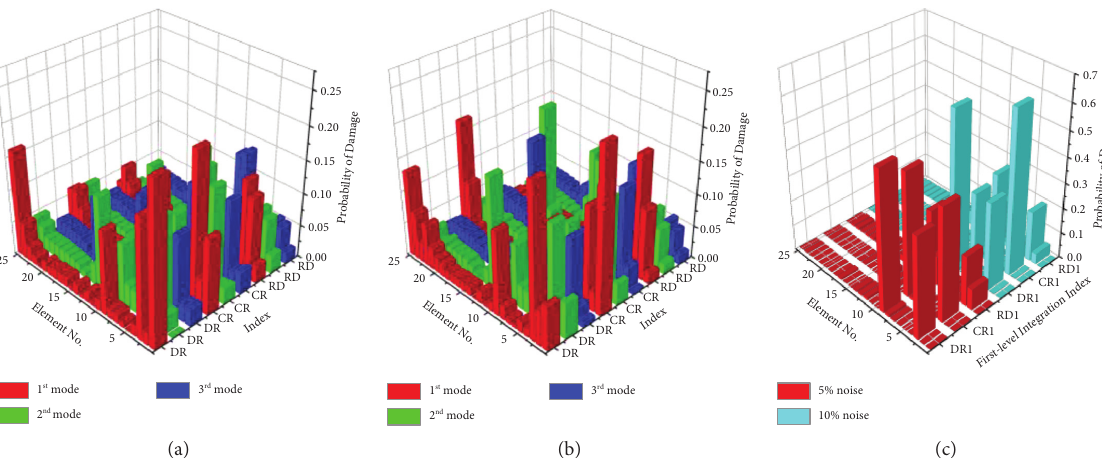
Figure 15: Antinoise analysis results of case 15. (a) 5% noise level of single index. (b) 10% noise level of single index. (c) 5%, 10% noise level of first-level fusion